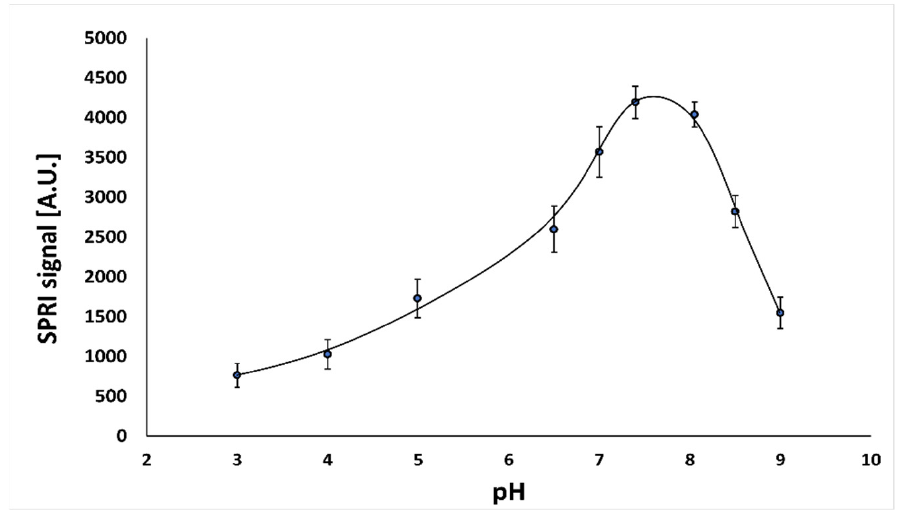
Figure 1. Dependence of SPRI signal (arbitrary units) for the antibody–cortisol complex on pH. The antibody concentration is 50.0 ng mL − 1 , and the cortisol concentration is 10.0 ng mL − 1 .